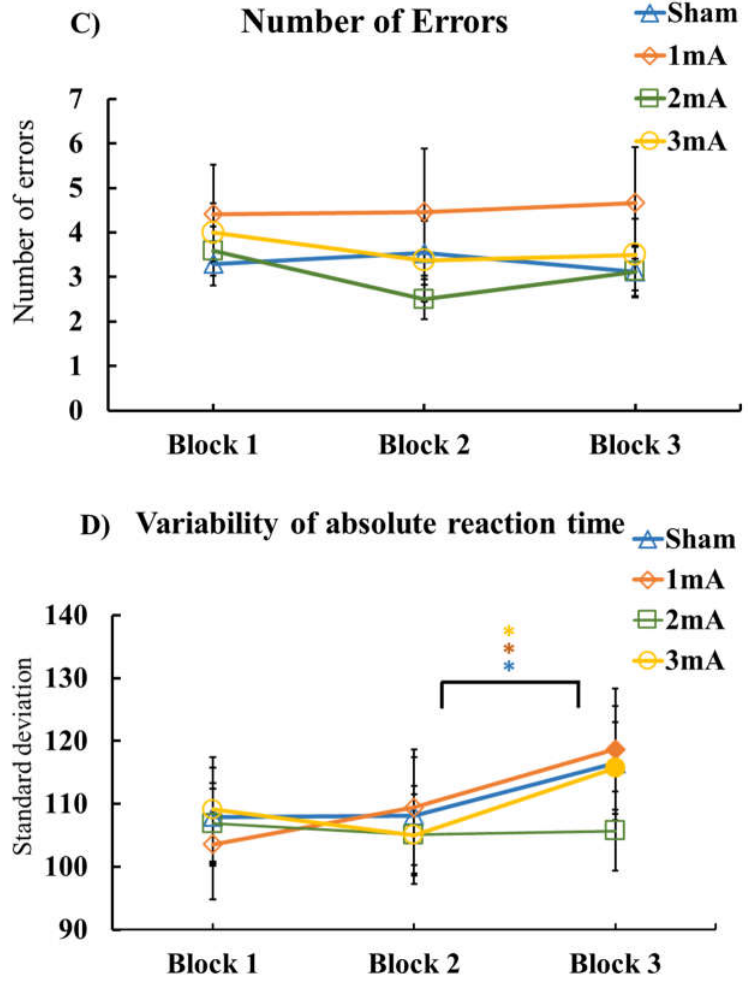
Figure 3. Results of R-SRTT. The graphs show ( A ) absolute reaction time, ( B ) normalized reaction time, ( C ) number of errors, and ( D ) variability of absolute reaction time of R-SRTT performance 24h after each tDCS protocol. Filled symbols indicate a significant difference in each block compared to block 1. Asterisks ( ⁎ ) refer to significant differences of block 2 to block 3 (both sequence blocks). Error bars represent standard error of means. Table 2. Effect of tDCS on R-SRTT. Results of the mixed-model ANOVAs conducted for R-SRTT: